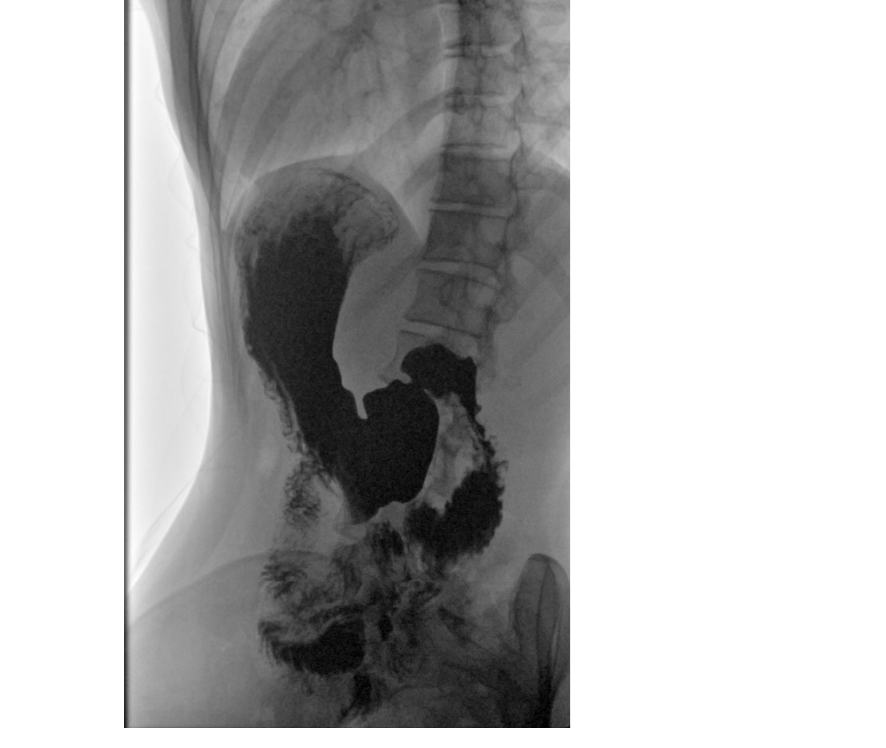
Figure 3. Efficient barium contrast emptying in supine position. The duodenum and intestines are devoid of pathologies.